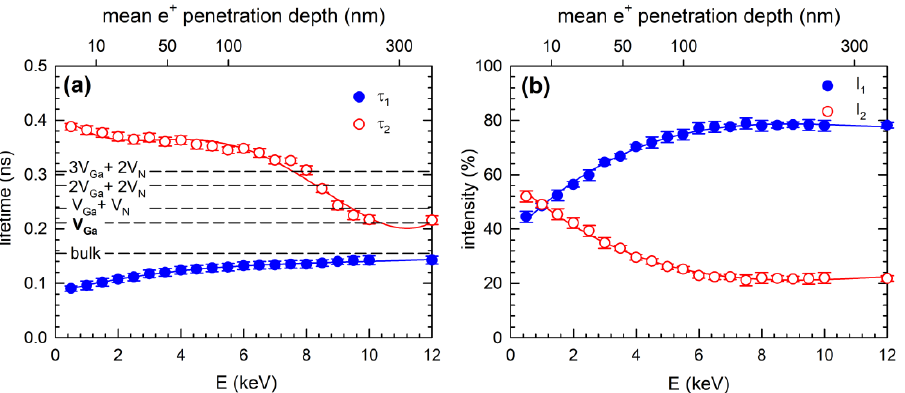
Figure 5. Breakdown results of positron lifetime spectra for sample TEH1 ( a ) lifetimes τ 1 and τ 2 of components resolved in spectra and ( b ) intensities I 1 and I 2 of the components. Dashed lines indicate calculated bulk positron lifetime and lifetimes of positrons trapped in various defects. The mean positron penetration depth is shown in the upper x -axis. The solid lines serve to guide the eye.